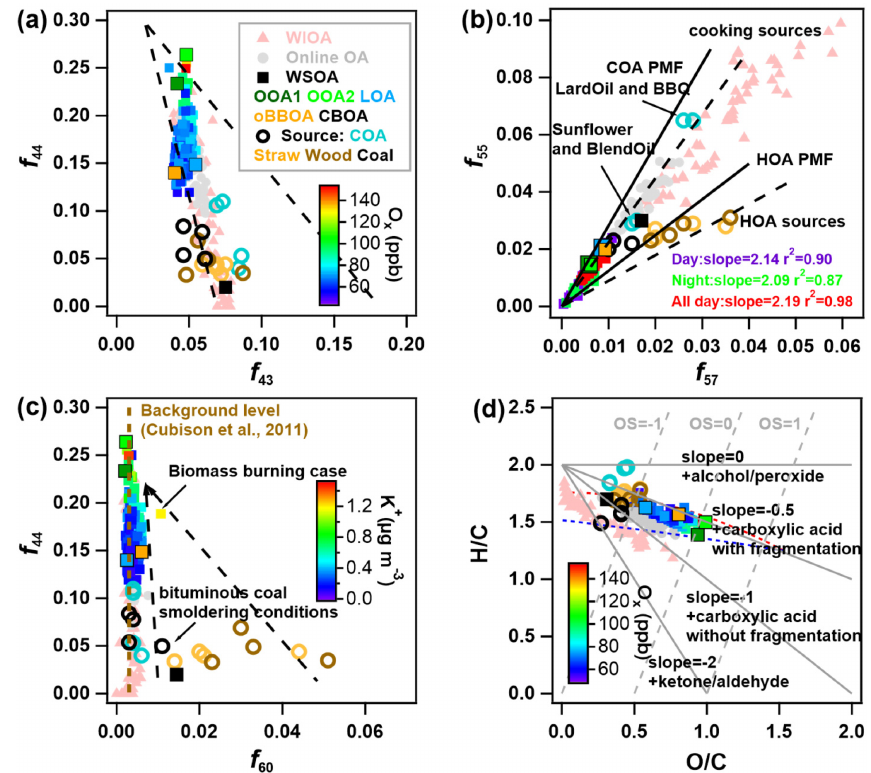
Figure 7. Triangle plots of (a) f 44 vs. f 43 ; the dash reference lines are adopted from Ng et al. (2010). (b) f 55 vs. f 57 ; the dashed and solid reference lines are adopted from Mohr et al. (2012). (c) f 44 vs. f 60 ; the dashed background level line and dashed reference lines are adopted from Cubison et al. (2011). (d) Van Krevelen diagram; the reference lines are adopted from Heald et al. (2010). The data results in the figures contain WSOA (colored squares), online OA (solid grey circles) and WIOA (pink triangles), and the open circles are the source experiment results adopted from Xu et al. (2020). Note that the contributions of water-soluble OOA factors (OOA1 and OOA2) to f 55 and f 57 in panel (b) were